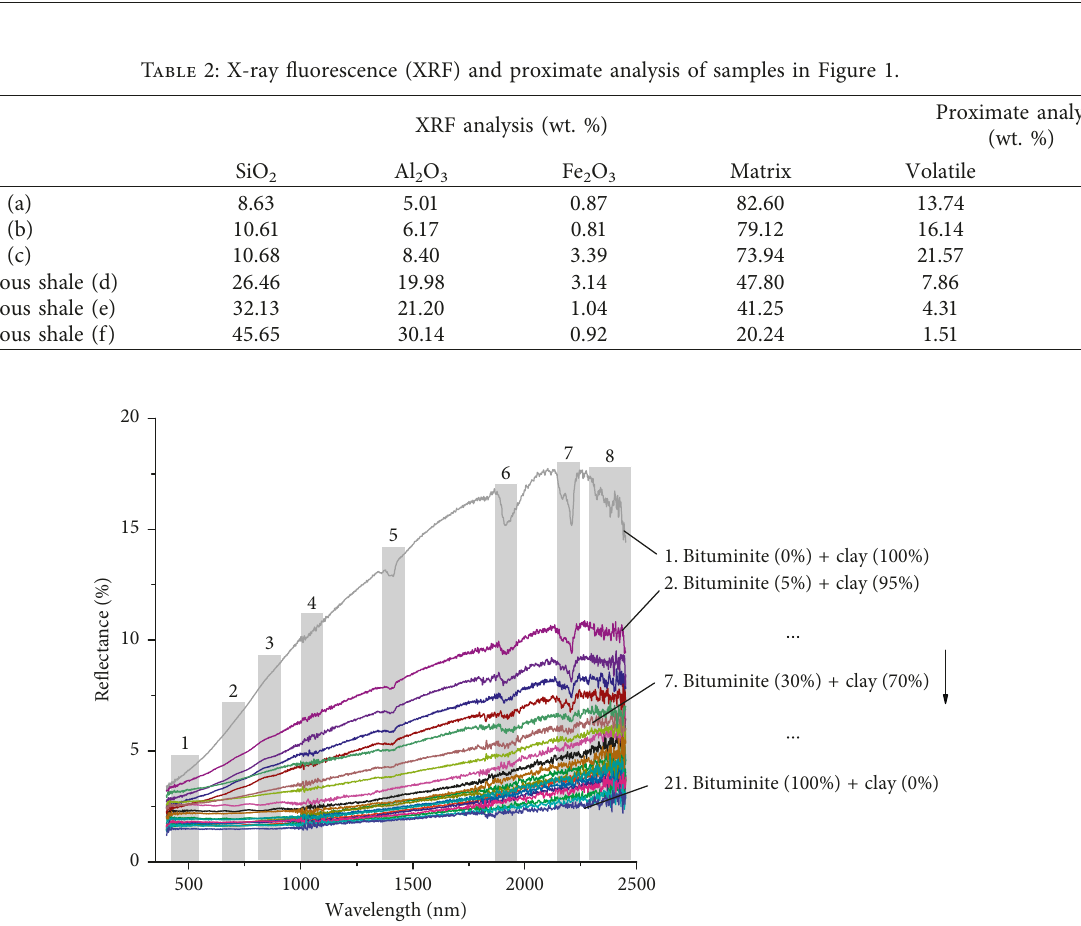
Figure 6: Spectral reflectance curves of 21 mixed powder samples of dry bituminite and clay in 0.5mm grain size under different mixing ratios in the wavelength range of